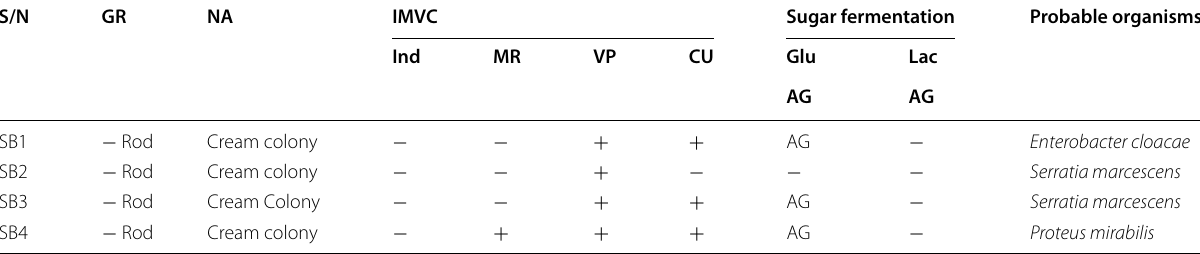
Table 2 Morphological and biochemical characterization of bacteria isolates from pre-solarized soil (without plastic and compost treatments)